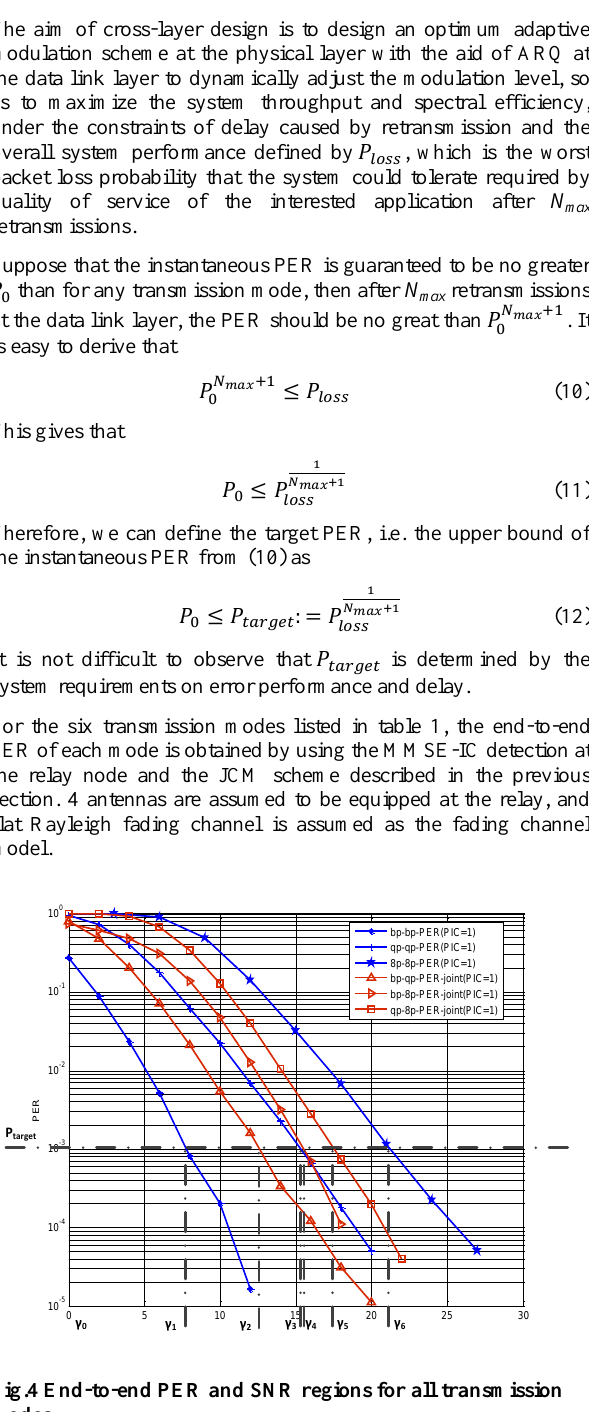
Fig.4 End-to-end PER and SNR regions for all transmission modes For the TWR transmission, the instantaneous PER of a chosen